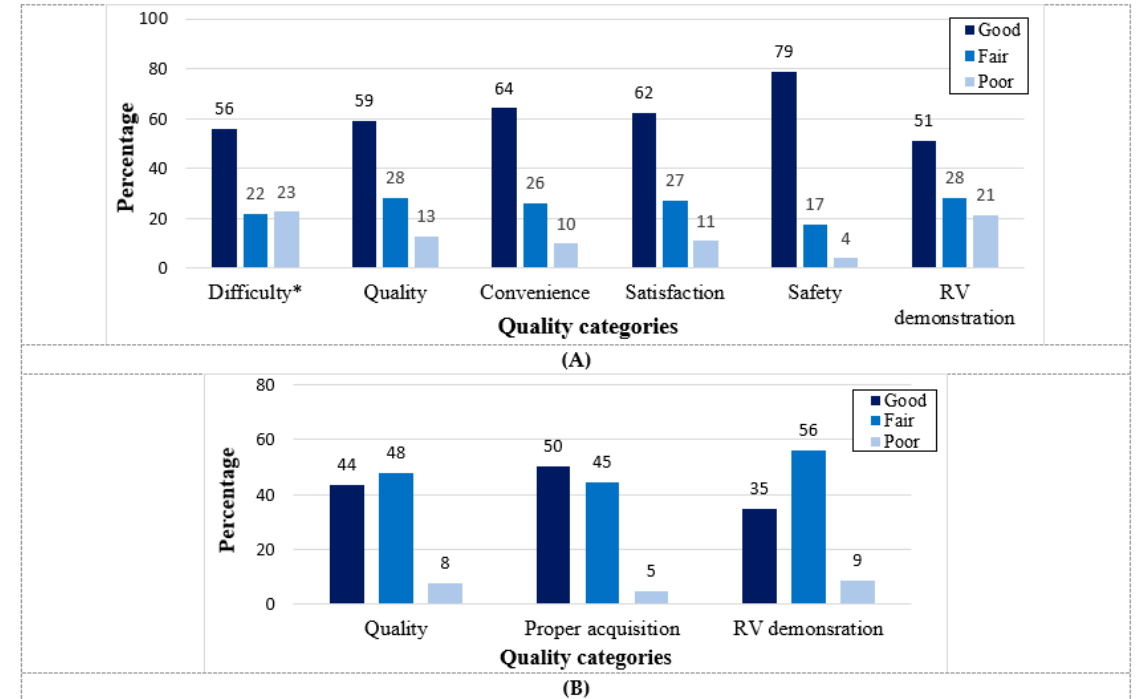
Figure 1. Quality, utilization and safety indices of hand-held echocardiogram according to operator and echocardiographer. Parameters were graded into three groups: Good, Fair and Poor. ( A ): Tech- nical variables of hand-held echocardiogram included the difficulty, general quality, convenience, satisfaction, safety and demonstration of the RV, as documented manually by the operator at the patient bedside. * The gradings for the difficulty category were the following: Not difficult, Fairly difficult and Very difficult. ( B ): Technical variables included general quality, proper acquisition and RV demonstration, as documented by the echocardiographer during offline evaluation. Abbreviation: RV, right ventricle. Reproduced from Dadon et al [34]. with permission from Wiley.